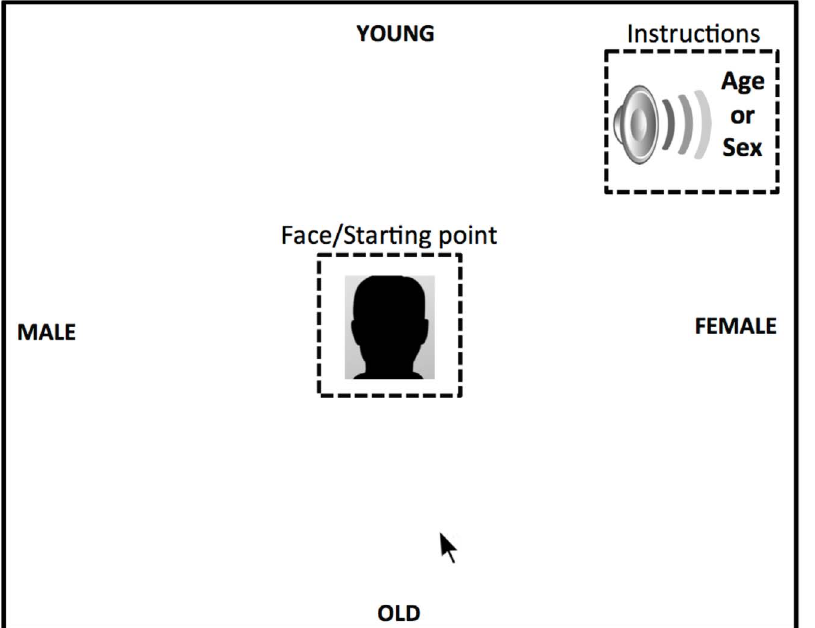
Figure 1. Figure displaying an example of the mouse procedure assessing the relative dominance of two social categories (i.e., sex and age) utilized in study 1a and 1b. During this task participants were given auditory instructions to categorize faces based on either their sex or their age.